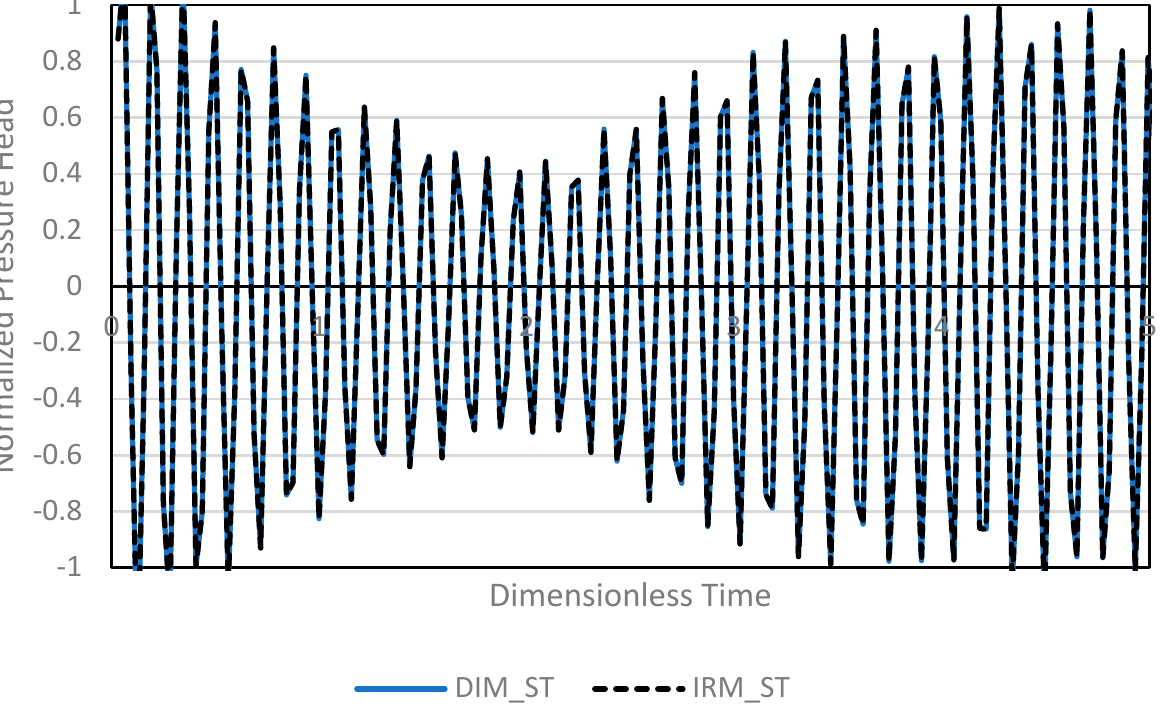
Figure 3. Predictions of normalized pressure head by DIM_ST and the IRM with surge tank (IRM_ST) adapted with permission from Ref. [11] at downstream valve.